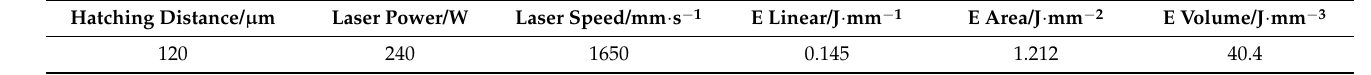
Table 1. Parameters used for printing bulk